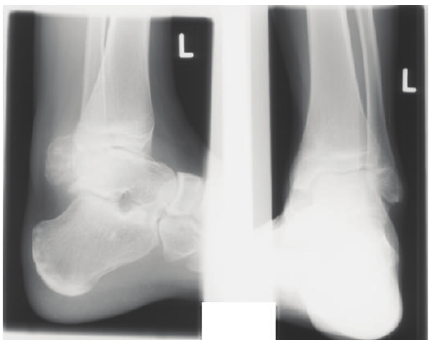
Figure 2: Plain radiography, anteroposterior and mediolateral view of the ankle joint.